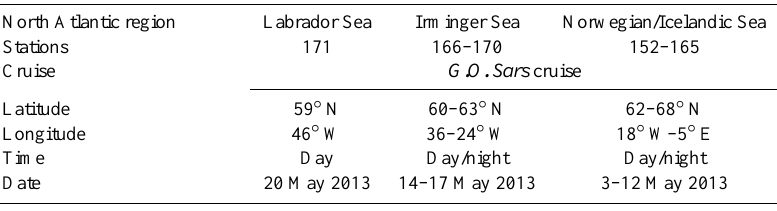
Table 6. G.O. Sars MOCNESS data set. List of jellyfish taxa collected in the 0–1000m layer, in different North Atlantic regions. Data from Licandro et al.